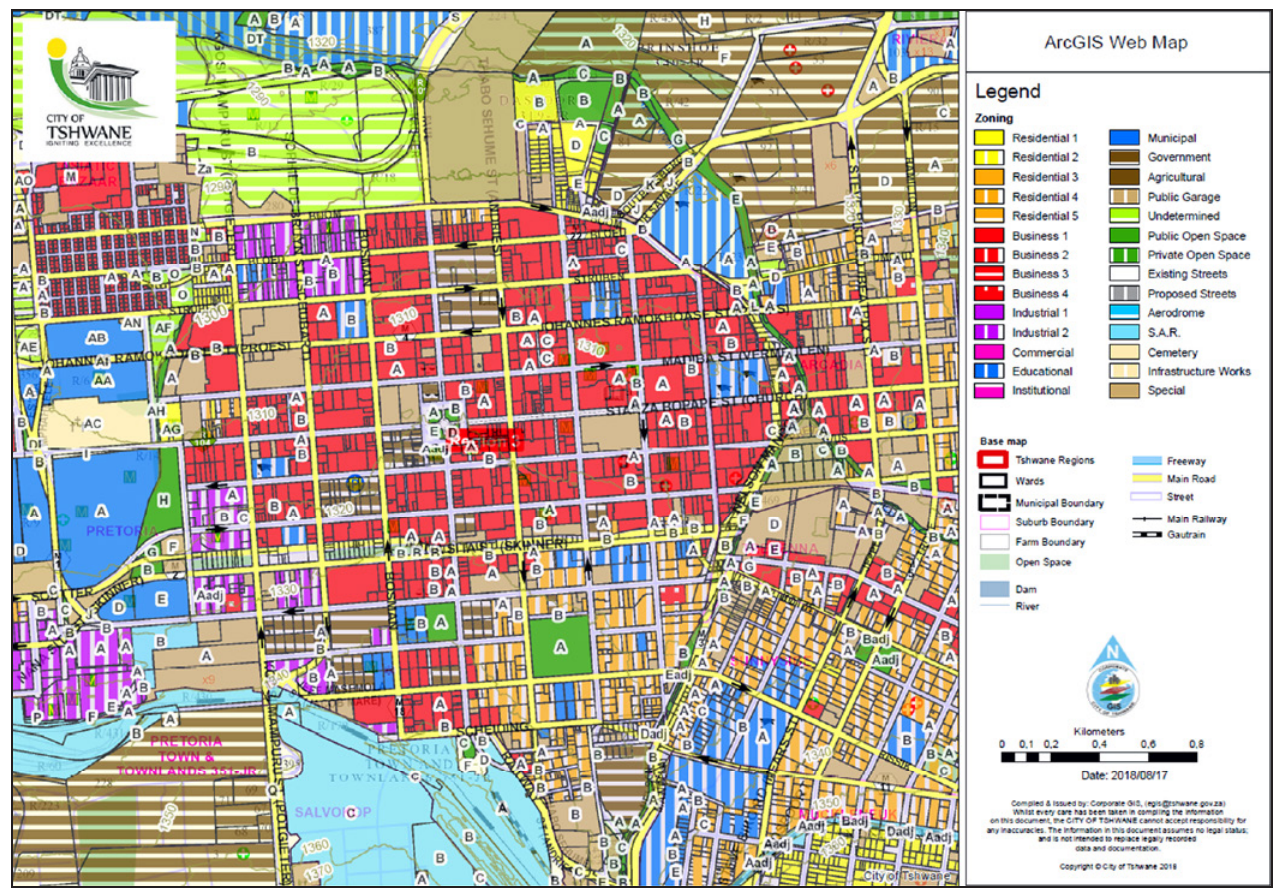
Figure 7: The type of zones and their distribution in the high-density central core of Pretoria Source: Tshwane online e-GIS